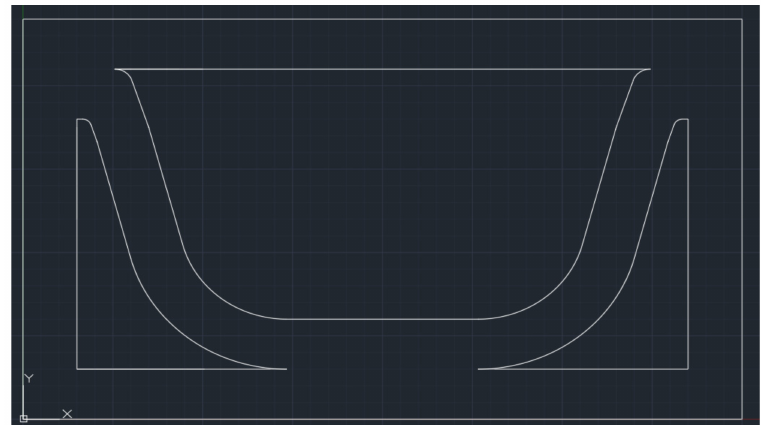
Figure 15. Apis Cor wall configuration